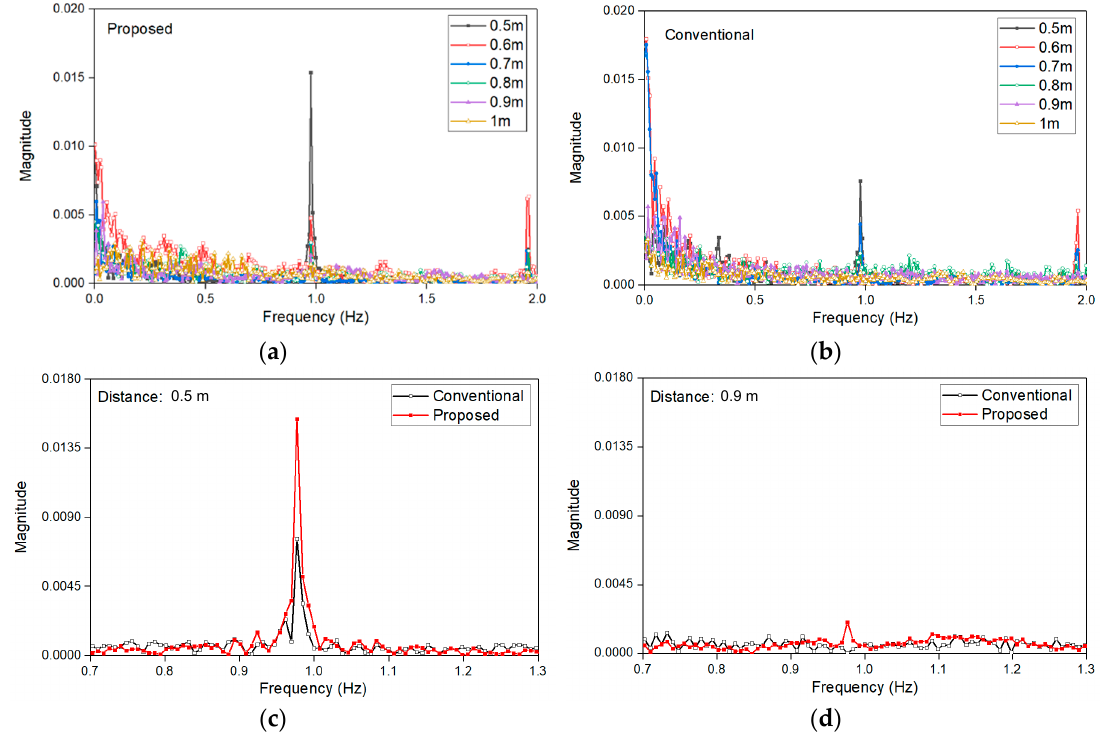
Figure 11. Received signal amplitude in the 2.45 GHz monostatic Doppler radar sensor: ( a ) using the proposed quasi-circulator at the distances from 0.5 m to 1 m; ( b ) using the conventional quasi-circulator at the distances from 0.5 m to 1 m; ( c ) at the distance of 0.5 m; ( d ) at the distance of 0.9 m.